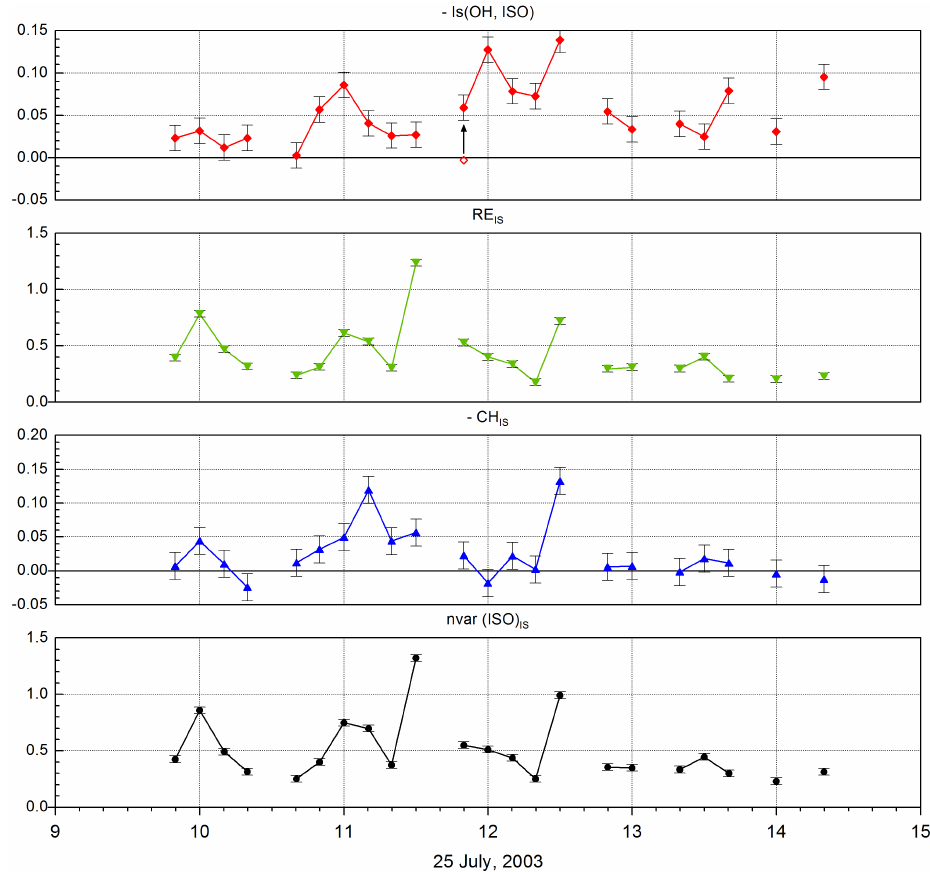
Figure 16. The four terms of Eq. (16) solved for RE is as a function of